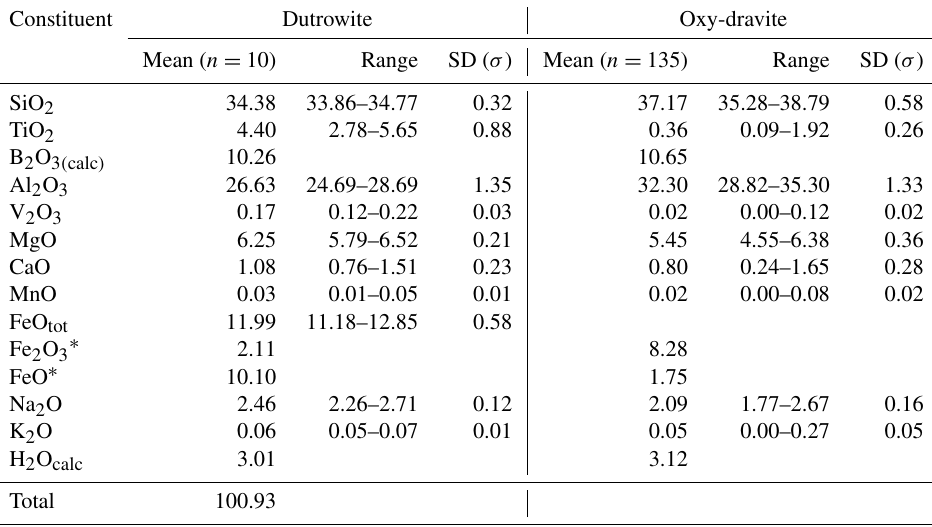
Table 2. Chemical data (in wt%) for dutrowite and associated oxy-dravite. Constituent Dutrowite